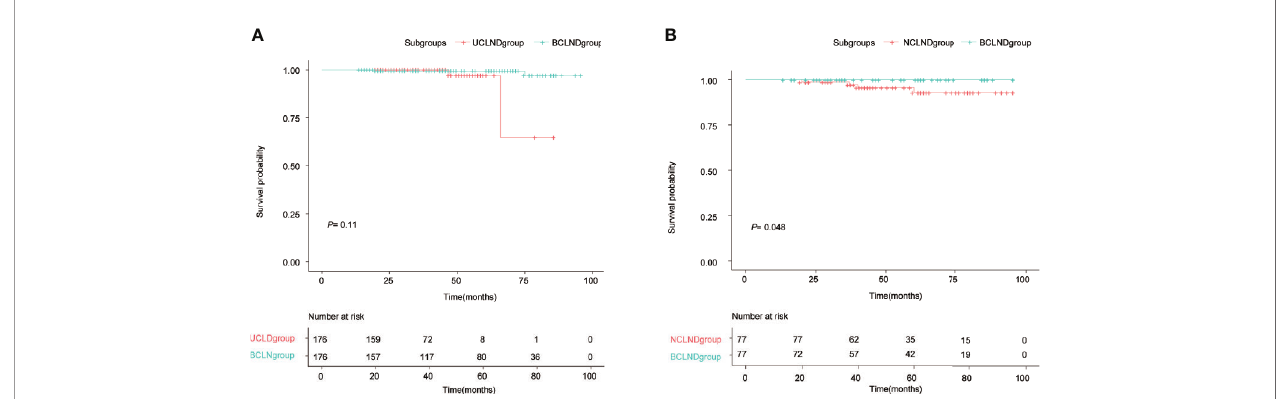
FIGURE 2 | Kaplan-Meier recurrence-free survival curves. (A) Kaplan-Meier recurrence-free survival curve of patients with isthmus PTC who underwent thyroidectomy with bilateral central neck dissection (BCLND) and who underwent thyroidectomy with unilateral central neck dissection (UCLND) ( P =0.11). (B) Kaplan- Meier recurrence-free survival curve of patients with isthmus PTC who underwent thyroidectomy with bilateral central neck dissection (BCLND) and who underwent thyroidectomy with no central neck dissection (NCLND) ( P